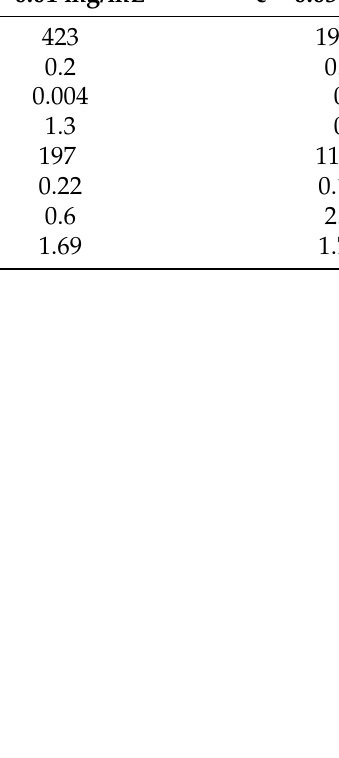
Figure 5. Confocal image of a T24 spheroid with 0.01 mg/mL collagen concentration (GFP cells in green; collagen in red). D ∼ 350 µ